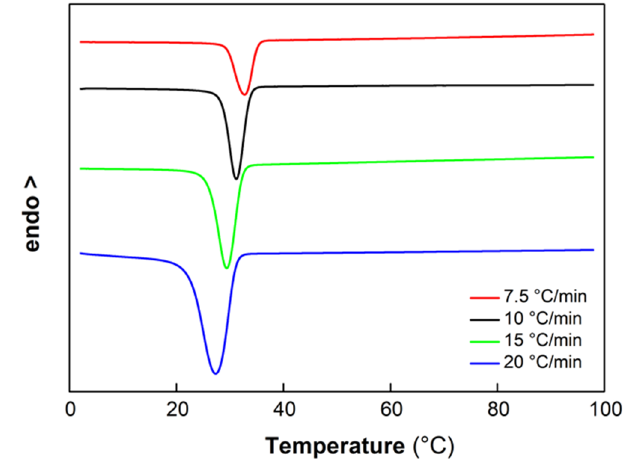
Figure 5. DSC cooling scans from the melt for PCL at different cooling rates.